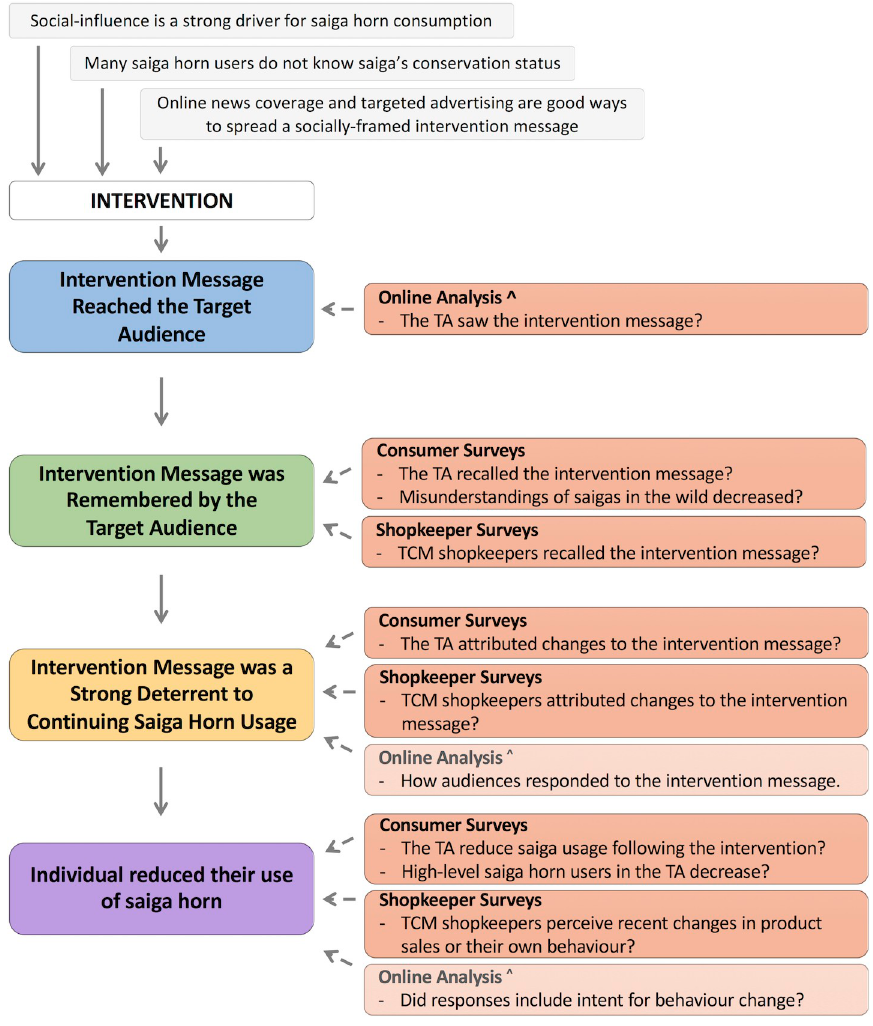
Fig 1. Evaluation theory-of-change, showing the dataset(s) used to assess assumed stages (blue, green, yellow, and purple boxes) resulting from the intervention. The top grey-boxed stages include assumptions underpinning the intervention and the intervention design. ^ See [24] for those initial stages and online analysis findings. The final two stages (yellow and purple) were assessed primarily using consumer and shopkeeper surveys, supported by the online analysis (indicated by transparent colouring). TA = target audience (middle-aged Chinese Singaporean women).